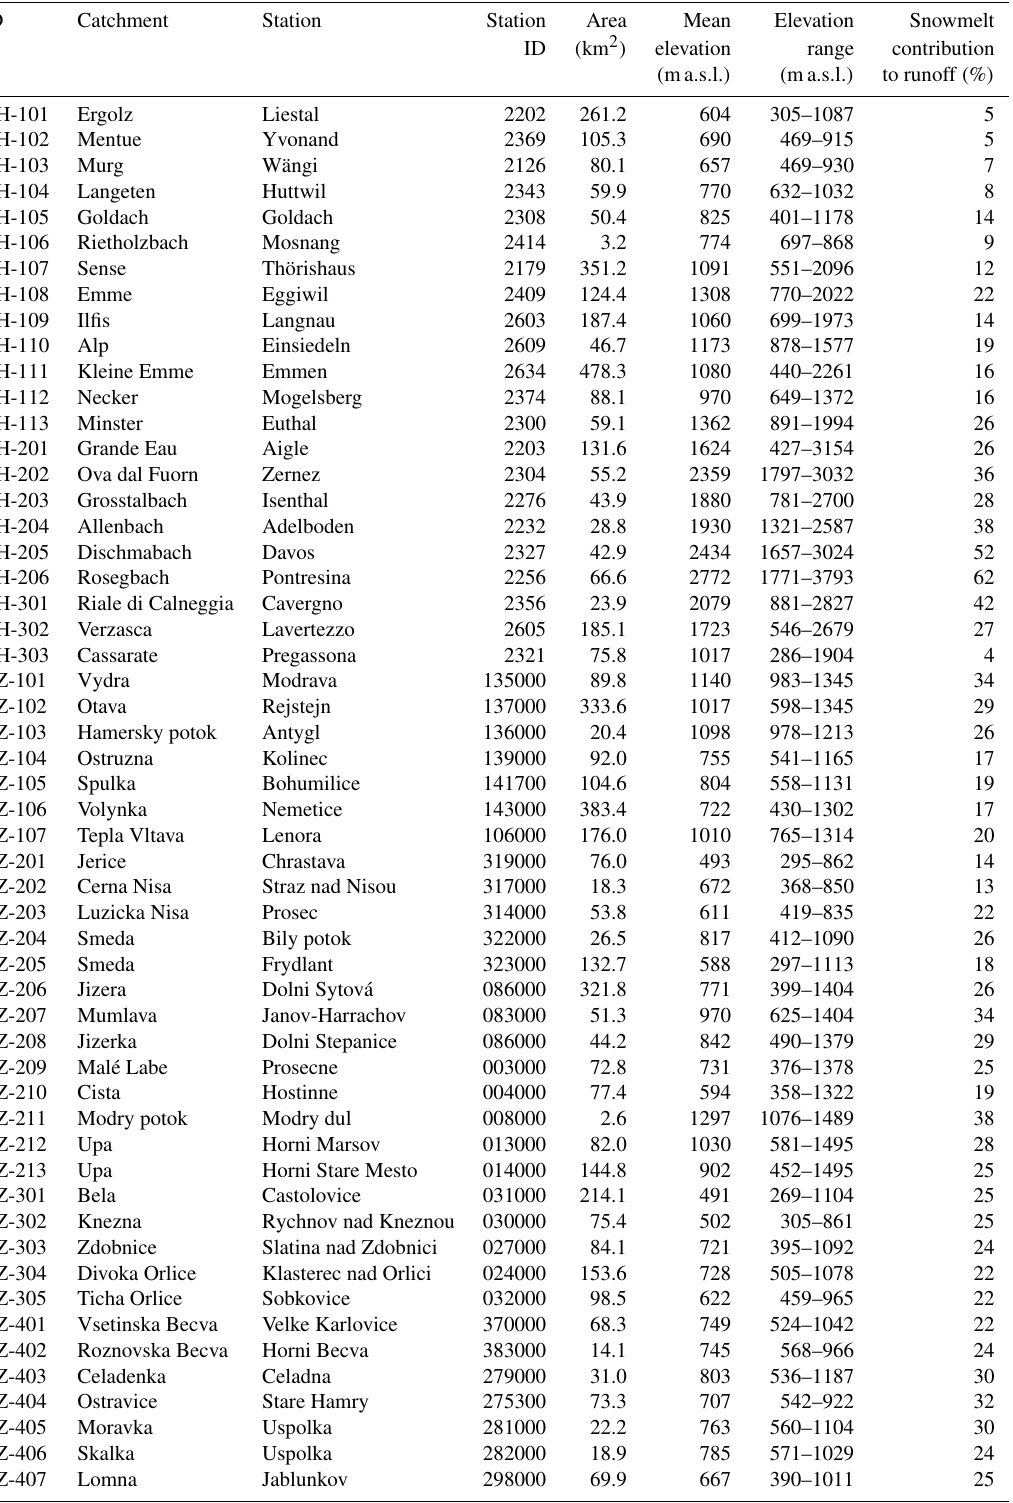
Table 2. Relevant physical characteristics of the catchments included in the study. Each catchment is given an identification code in the following way: country (CH – Switzerland, CZ – Czechia), geographical location (Switzerland: 100 – Jura and Swiss Plateau, 200 – Central Alps, 300 – Southern Alps; Czechia: 100 – Bohemian Forest, 200 – Western Sudetes, 300 – Central Sudetes, 400 – Carpathians) and a sequential number for increasingly snow-dominated catchments within each geographical setting. The official hydrometric station IDs from FOEN and CHMI are also provided (four- and six-digit numbers in column station